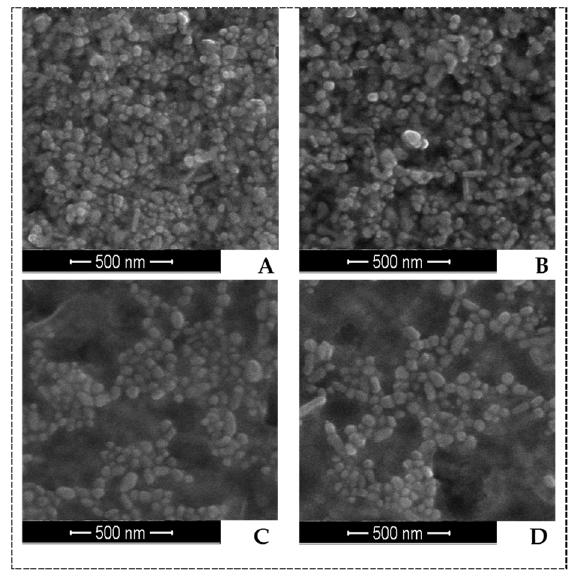
Figure 3. Scanning electron microscopy micrographs of AgNPs (scale 500 nm): ( A ) AgNPs-C, ( B ) AgNPs-H2, ( C ) AgNPs-H10, and ( D ) AgNPs-H20; synthesis at 70 °C.